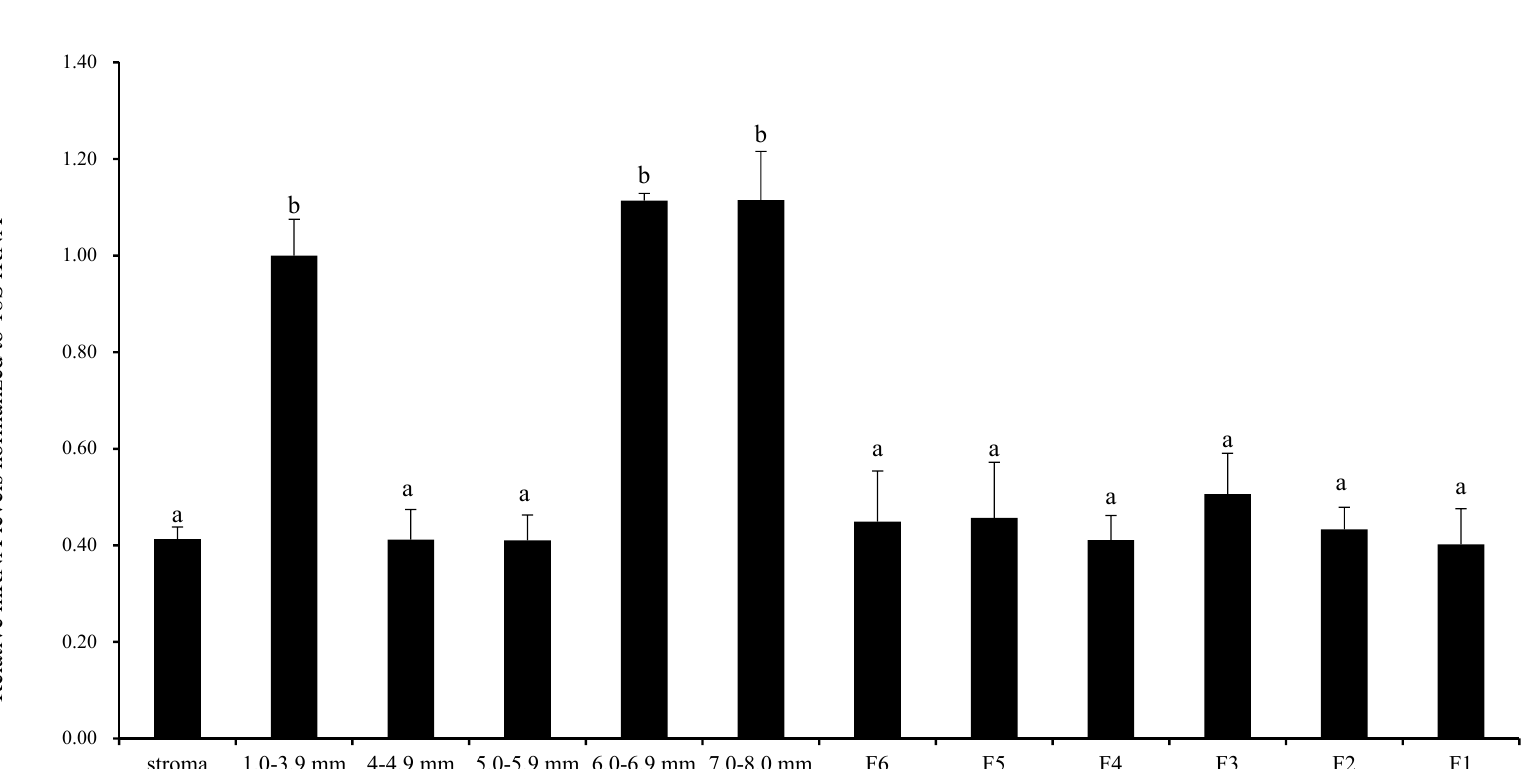
Figure 1. Quantification of RAC1 mRNA expression by RT-qPCR analysis in di ff erent-sized ovary follicles. It was normalized with respect to 18S rRNA . The stroma from the ovary contains matrix tissue from large follicles ( ≥ 1 mm in diameter), small follicles ( < 1 mm in diameter), atretic follicles, somatic and other cells. Represented are means and standard error of means (mean ± SEM) of data from chickens ( n = 10). Values with unlike superscripts designate a statistically significant di ff erences ( p < 0.05).